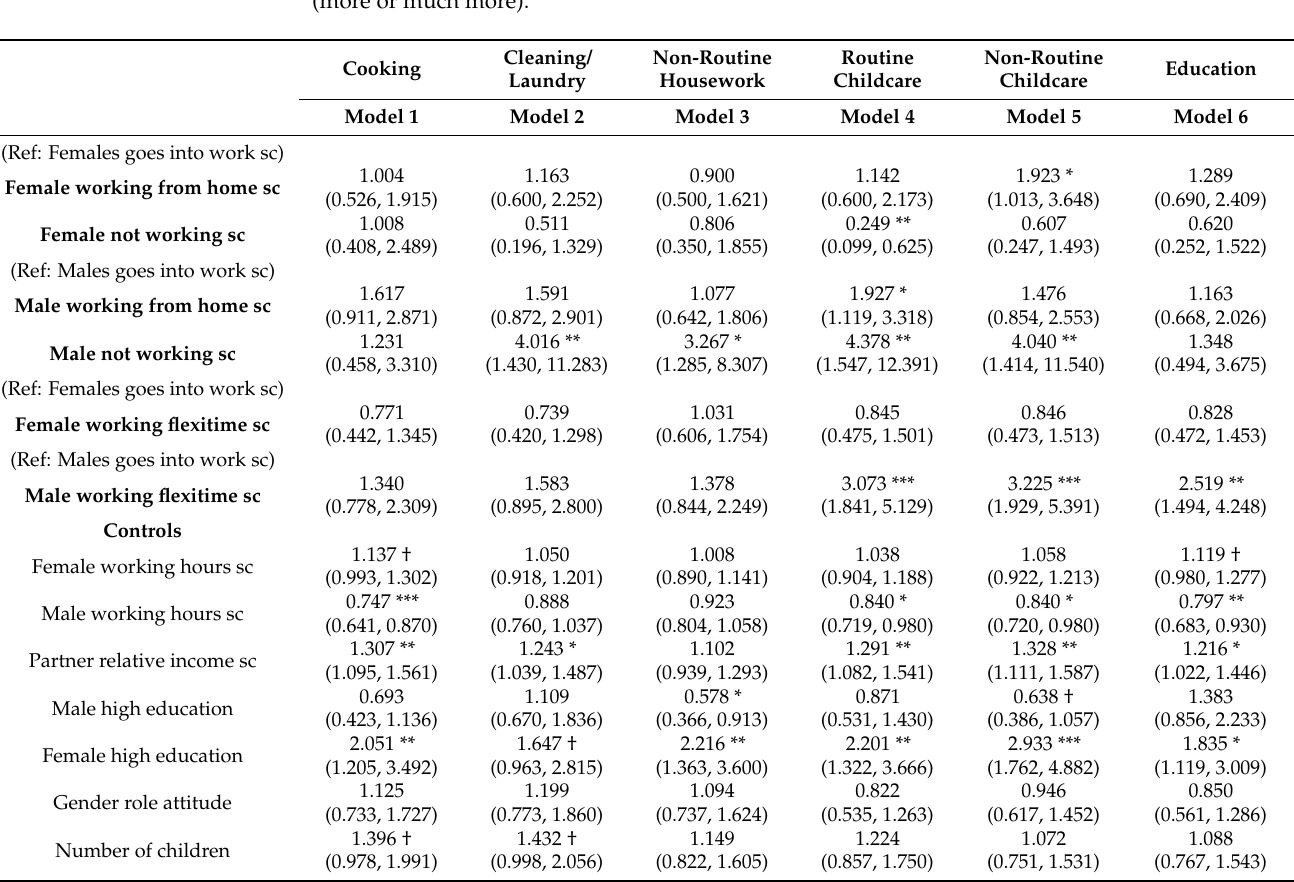
Table A4. Model explaining the changes in the amount of housework and childcare men carried out during the COVID-19 lockdown compared to before the lockdown for heterosexual dual earning couples with children under 18 (female respondents’ perception of their partners’ time)—dichotomous (more or much